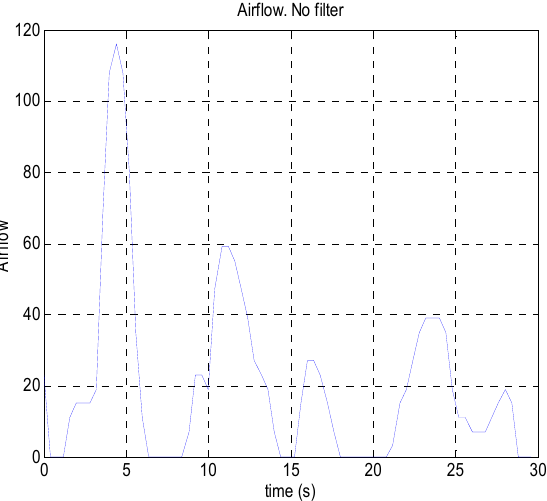
Figure 12. Airflow sensor tested; the user takes two deep breaths followed by two moderate ones. No filtering is used.